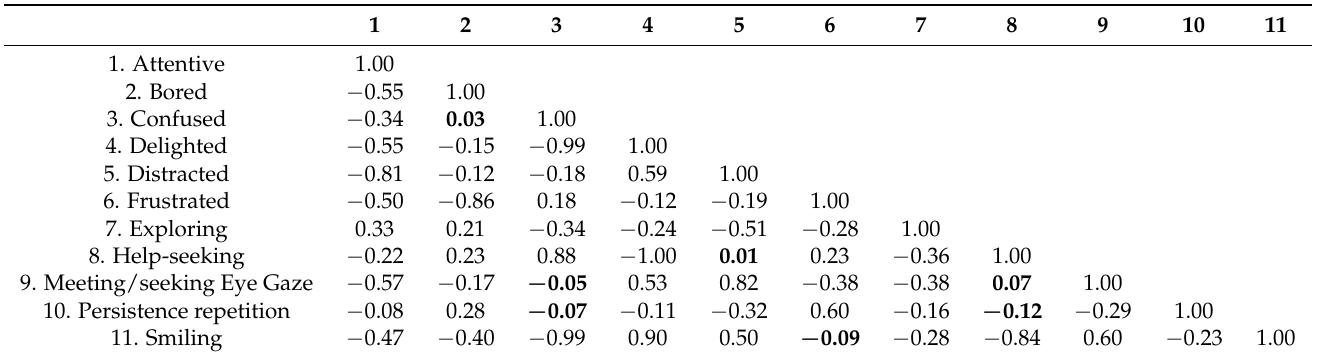
Table 2. Correlation coefficients depicting the degree of association among observed behavior and affect states.